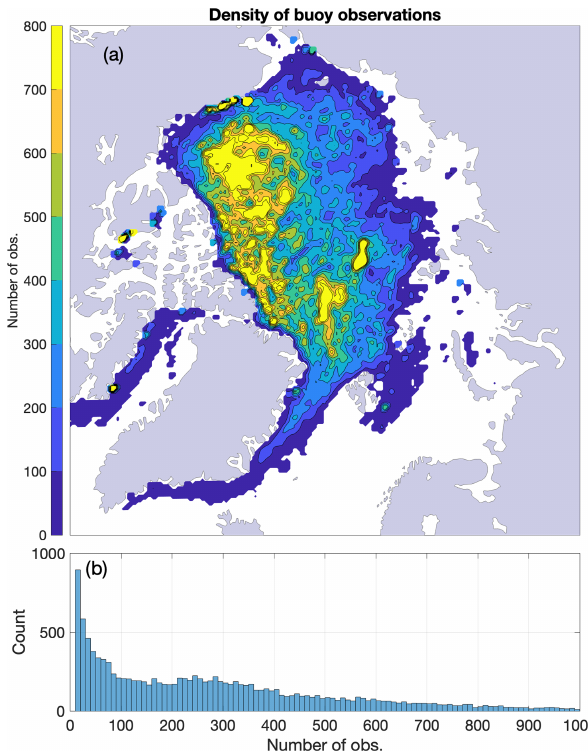
Figure 1. (a) Based on the density of IABP buoy drift data over the full 1979–2019 period: spatial map of the number of data points used for the evaluation of the surface currents U w (and α when applicable) at every grid location. (b) Distribution of the number of points in grid